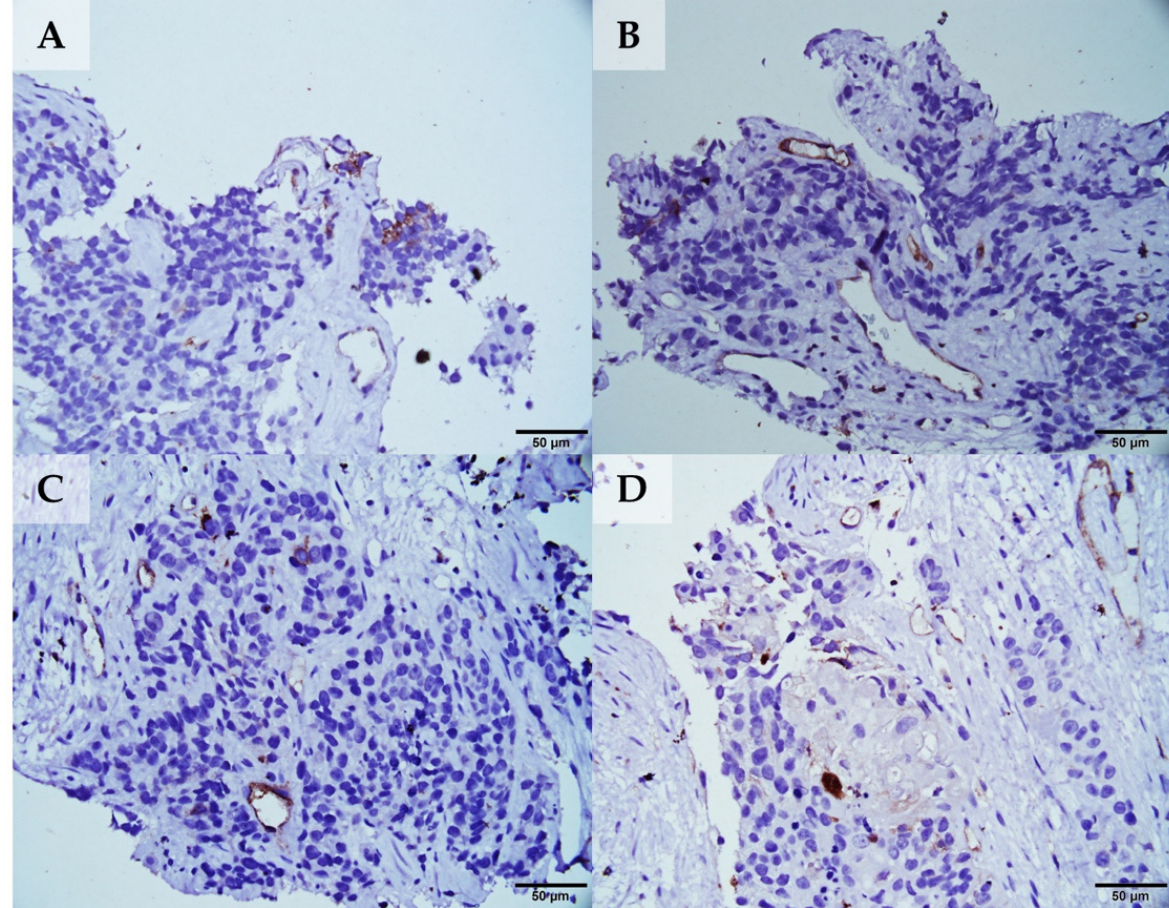
Figure 2. Display of immunohistochemistry of a liver metastasis ( A – D ) obtained from patient #2 (also refer to Figure 1). Staining for CXCR4 was rated weak (score of 1) with only single tumor cells (<5%) demonstrating chemokine receptor positivity. Magnification: 600×.